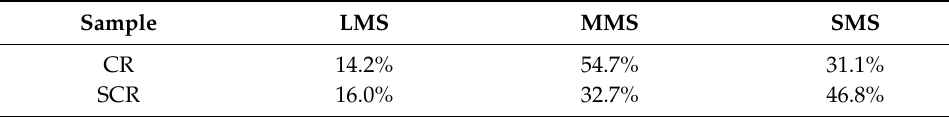
Figure 14. Chromatogram of CR and SCR. Table 8. Relative proportion of three regions of CR and SCR.